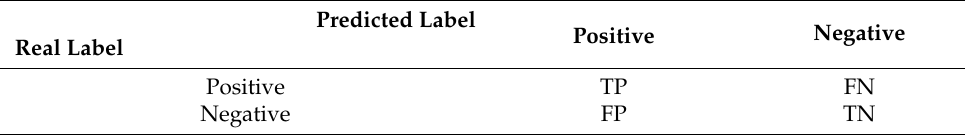
Table 3. The confusion matrix for a binary classification problem.